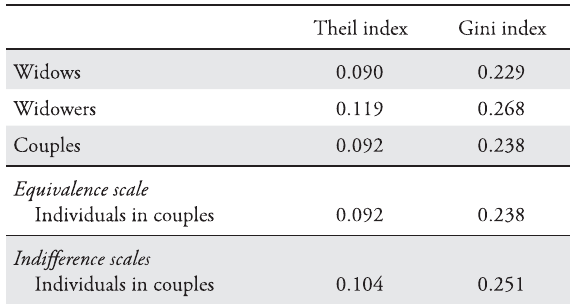
Table 7: Consumption Inequality Theil index